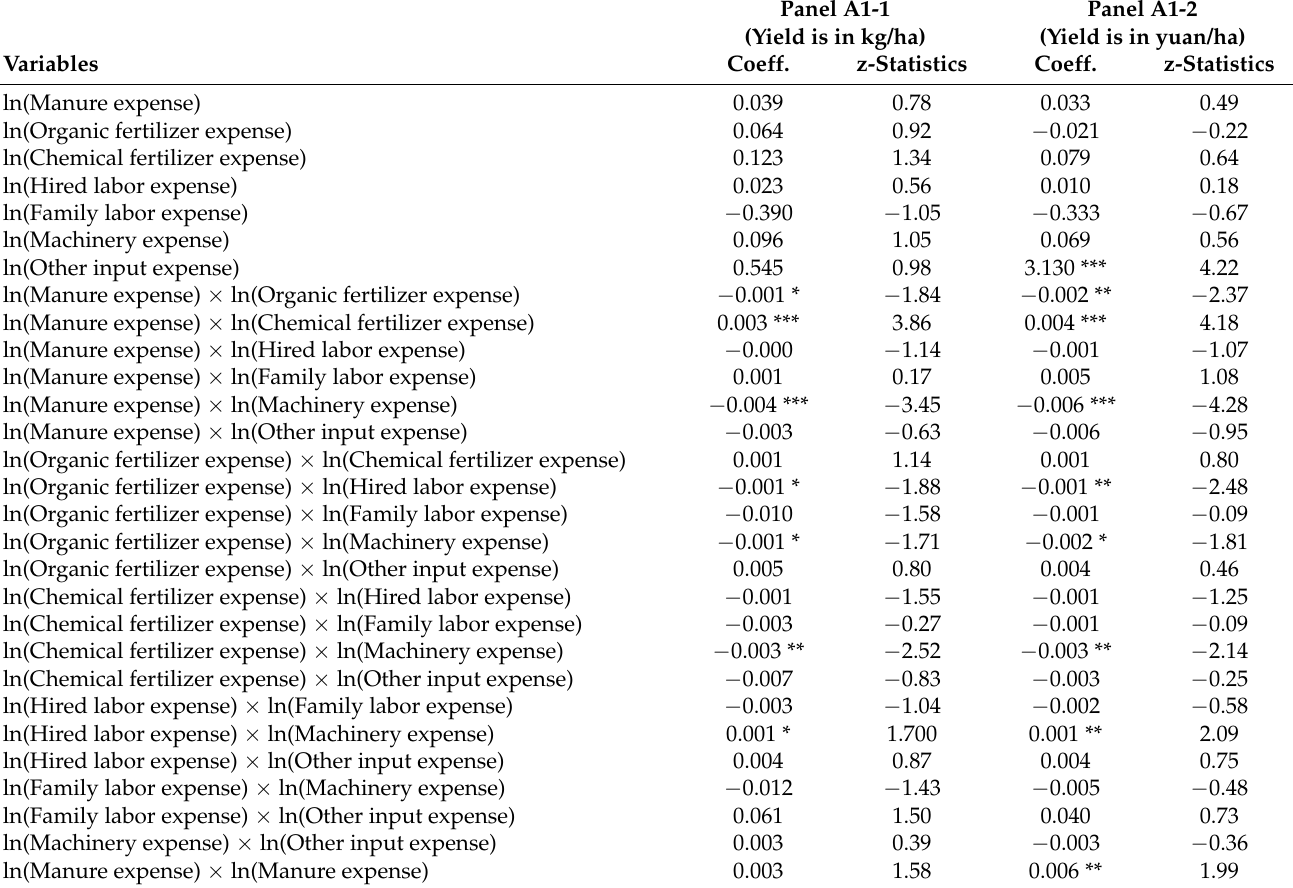
Table A1. Production function estimation results with inputs measured in value